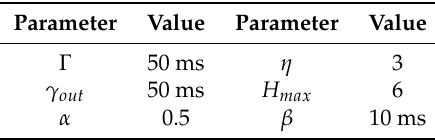
Table 3. ILBFC protocol